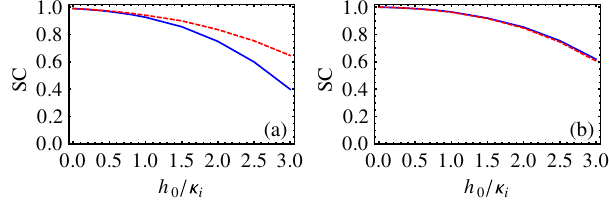
FIG. 6. Switching contrast as a function of the intrinsic cou- pling for (a) Stark control and (b) shuffle control. The solid blue lines indicate the output (cid:2) ð 1 Þ out , while the dashed red lines are for the output (cid:2) ð 2 Þ out . The time averages of T on and T off in Fig. 5 are used to evaluate the switching contrast. In (a), T on is evaluated t ¼ 1 : 5 to 2 for (cid:2) ð 1 Þ out and from (cid:4) t ¼ 2 : 5 to 3 for (cid:2) ð 2 Þ out ; T off from (cid:4) i i t ¼ 2 : 5 to 3 for (cid:2) ð 1 Þ out and from (cid:4) t ¼ 3 : 5 to 4 is calculated from (cid:4) i i t ¼ for (cid:2) ð 2 Þ out . In (b), T on is the average transmission between (cid:4) i 1 : 8 and 2.1 for (cid:2) ð 2 Þ 0 : 8 and 1.1 for (cid:2) ð 1 Þ out and between (cid:4) i t ¼ out ; T off t ¼ 1 : 5 to 2 for (cid:2) ð 1 Þ out is averaged over the time period from (cid:4) i